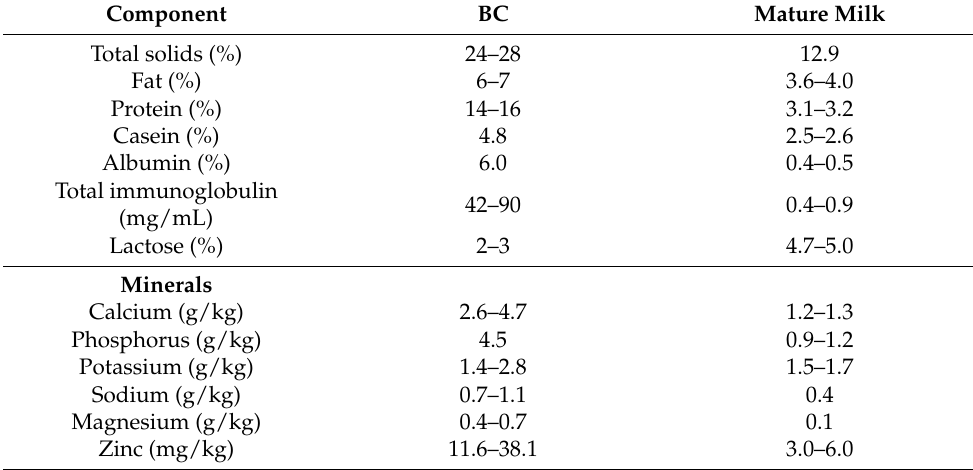
Table 1. Concentrations of select macronutrients, micronutrients, immunoglobulins, and general antimicrobial peptides present in bovine colostrum (BC) and mature